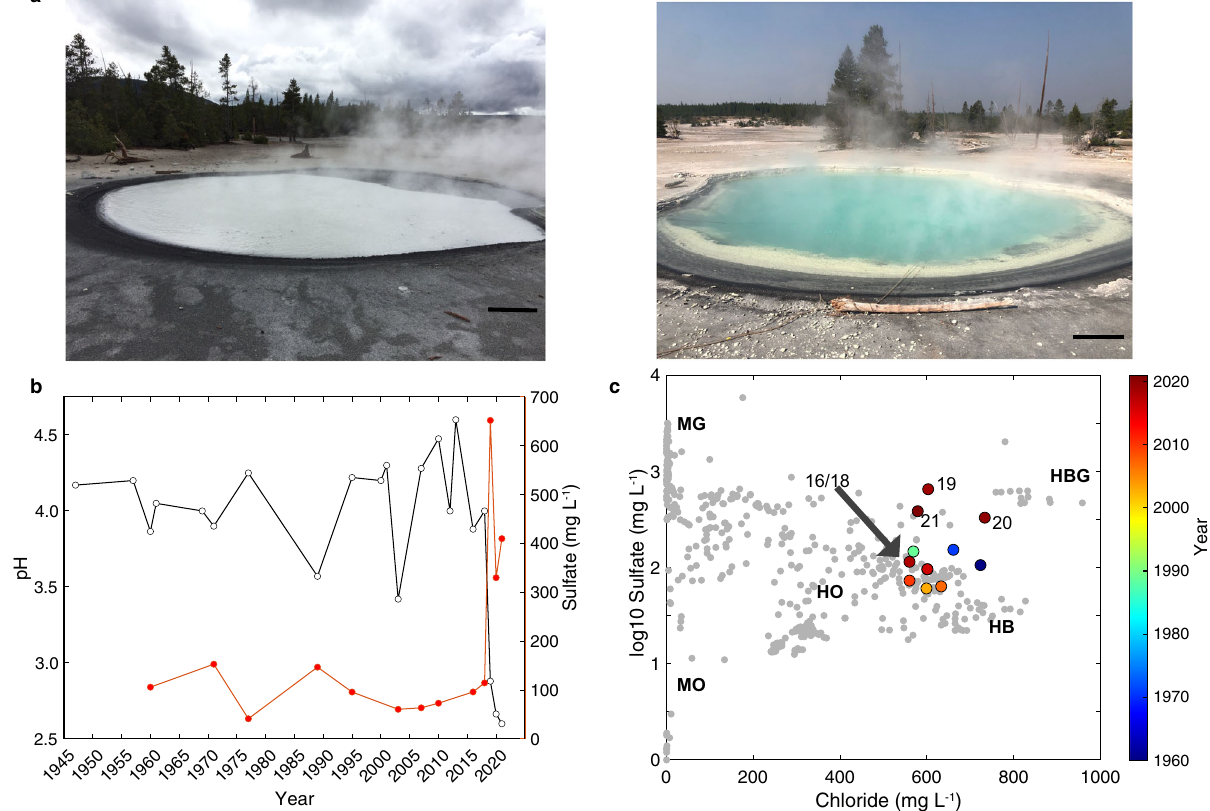
Fig. 1 Historical geochemistry of Cinder Pool (CP). a Top panel shows the visual change in the appearance of CP in 2016 (left) and 2020 (right). Scale bars in the bottom right are ∼ 1 m. b Measurements of pH ( n = 21; black line) and sulfate (SO 4 2 − ) concentrations ( n = 12; red line) in CP waters between 1947 and 2021. Years with multiple measurements were averaged to represent the entire year. c Paired measurements of SO 4 2 − and chloride (Cl − ) concentrations ( n = 12) between 1947 and 2021 in the context of the same measurements for 488 YNP springs derived from previous studies. Paired points for CP are colored based on the year they were recorded (averaged for multiple measurements/year as described above). End member fl uid compositions as described in the manuscript text are indicated based on the abbreviations: MO meteoric only, HO hydrothermal only, MG meteoric plus gas, HB hydrothermal plus boiling, HBG hydrothermal plus boiling plus gas. Points for 2016, 2018, 2019, 2020, and 2021 are indicated by “ 16 ” , “ 18 ” , “ 19 ” , “ 20 ” , and “ 21 ” ,